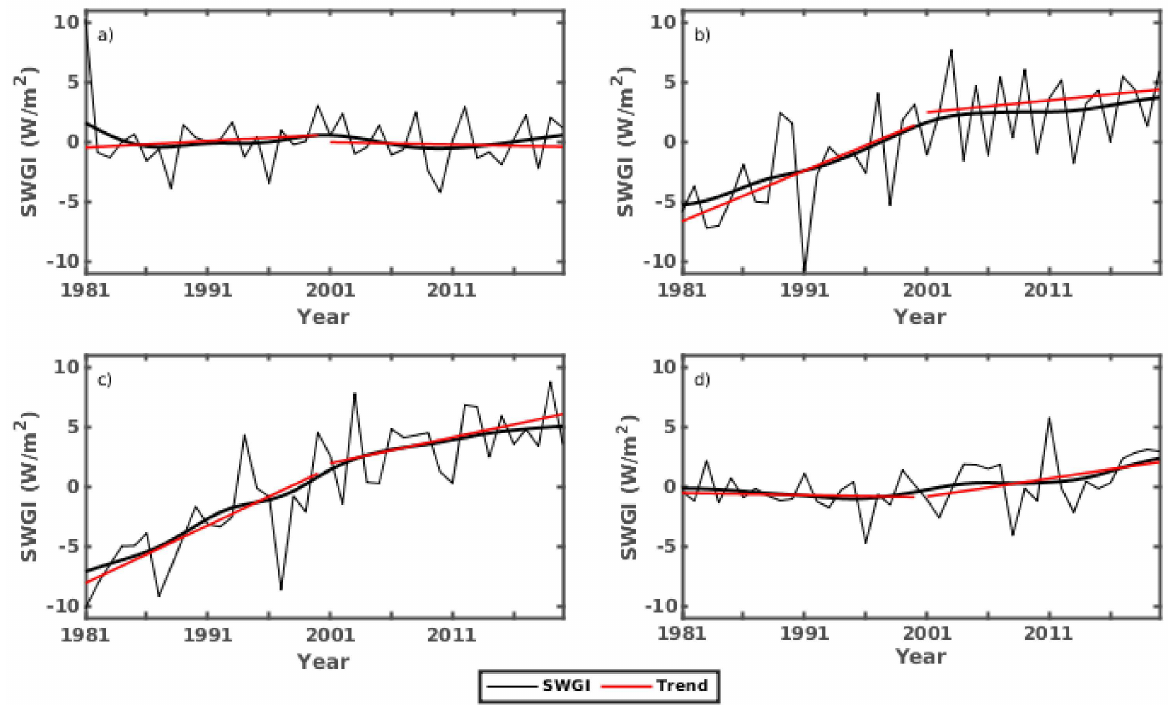
Figure 14. Temporal variation of the composite annual SWGI averaged in the Euro-Mediterranean area from ERA5-Land dataset for the 1981–2020 period (grey line) plotted together with a 5 year Gaussian low-pass filter (black thick line) and trend lines for the periods 1981–2000 and 2001–2020 (red lines) for ( a ) winter (DJF); ( b ) spring (MAM); ( c ) summer (JJA); and ( d ) autumn (SON). The SWGI series is expressed as anomalies from the 1981–2020